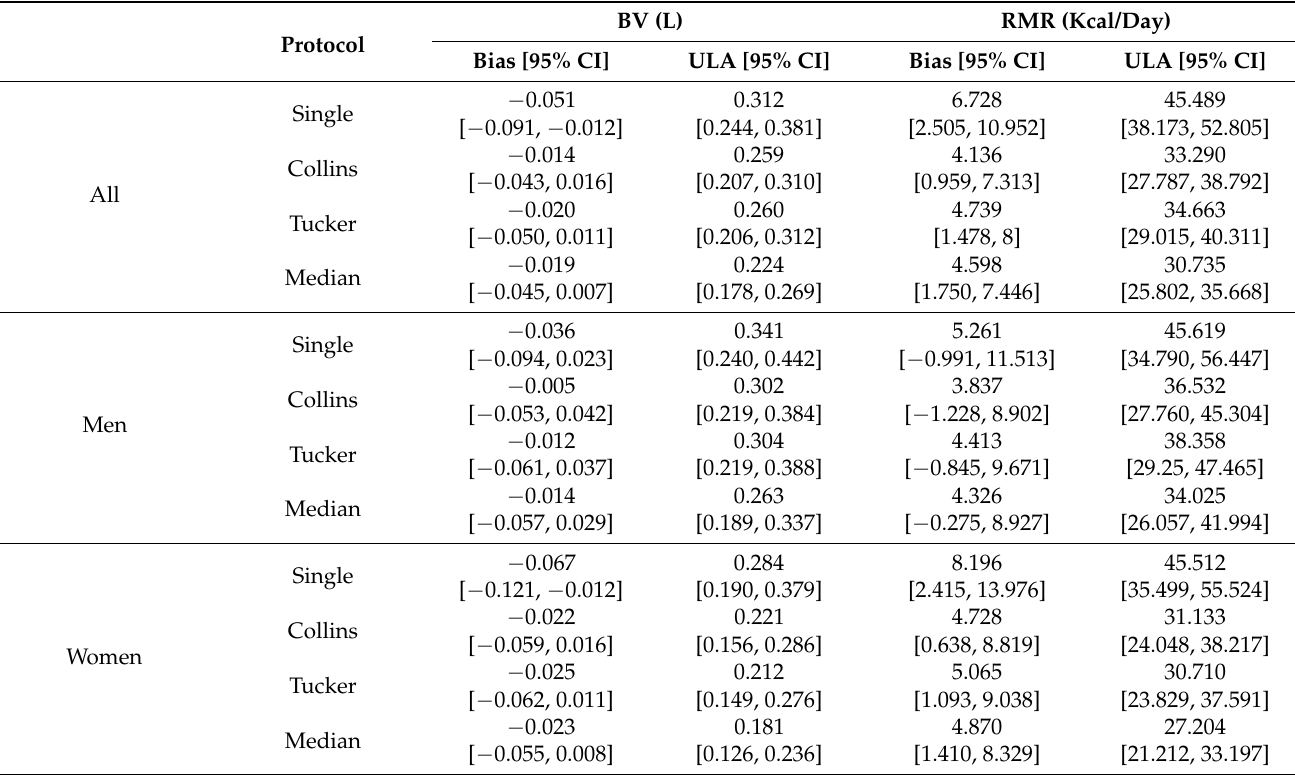
Table 3. BA parameters for the reliability BV measurements and RMR